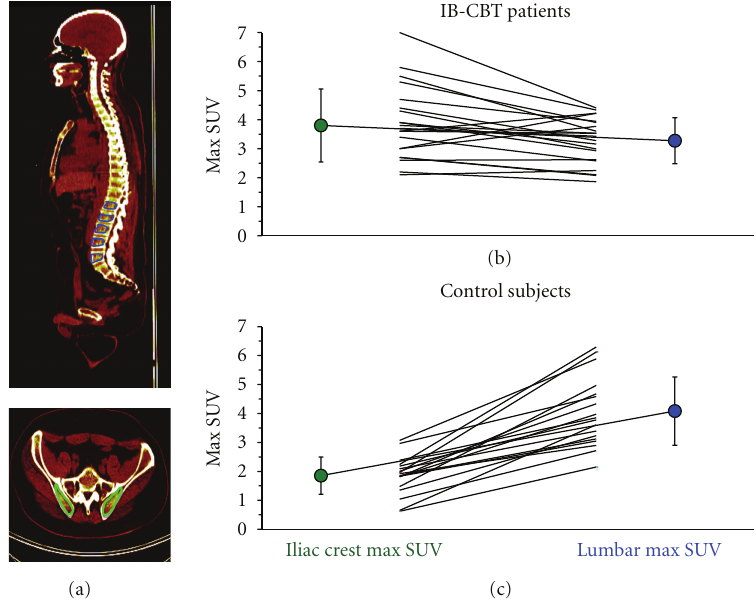
Figure 1: (a) Bone marrow (BM) segmentation of both iliac crests (bottom) and five lumbar vertebrae (top), using PET-CT images. Analyzed volumes are shown in green for the former and blue for the latter. (b) Metabolic activity trend patient by patient in the injected sites compared with remote BM; maximal SUVs in the iliac crests were slightly but significantly higher than in the lumbar spine. On the contrary, the same analysis (c) showed the opposite results in